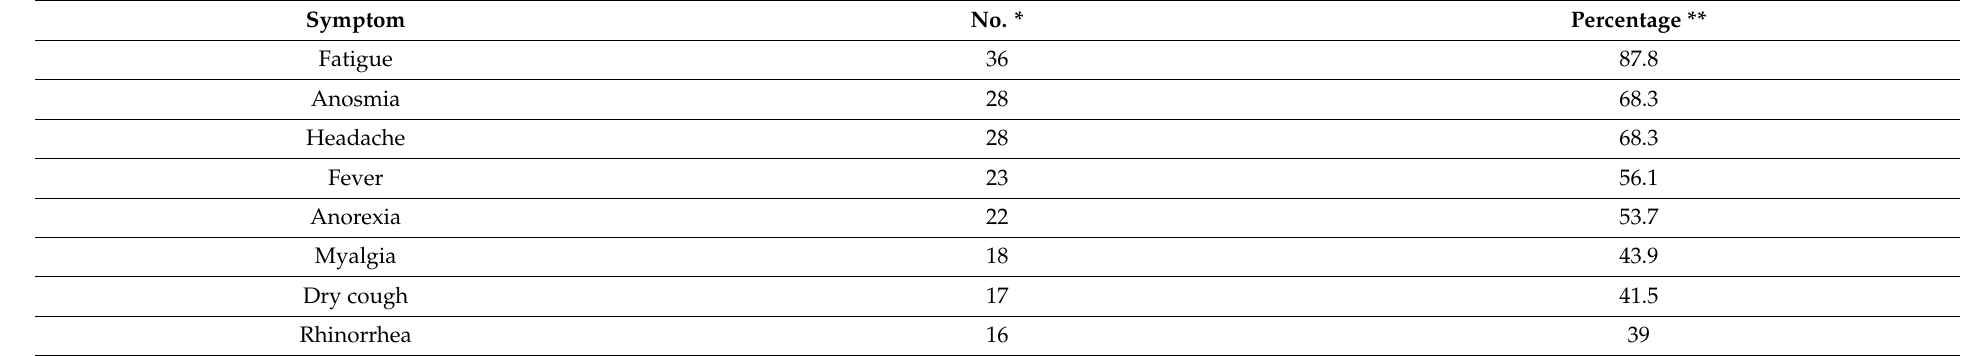
Table 2. Presentation of the COVID-19 symptoms in healthcare workers with the history of laboratory-confirmed COVID-19